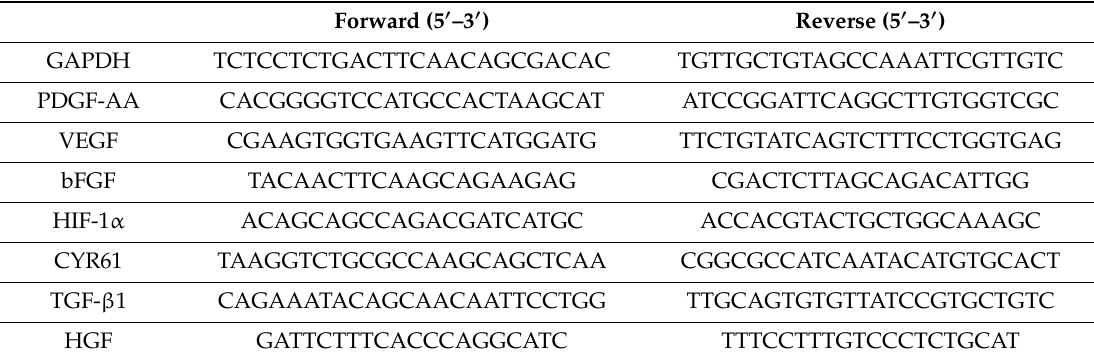
Table 2. Primers used for